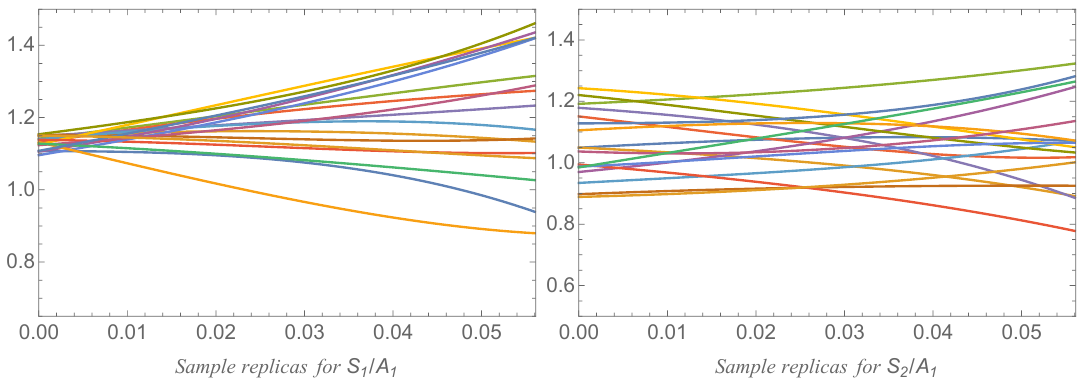
Figure 1 . Sample replicas which satisfy all requirements for the form factor ratios S 1 ; 2 =A 1 as a function of z